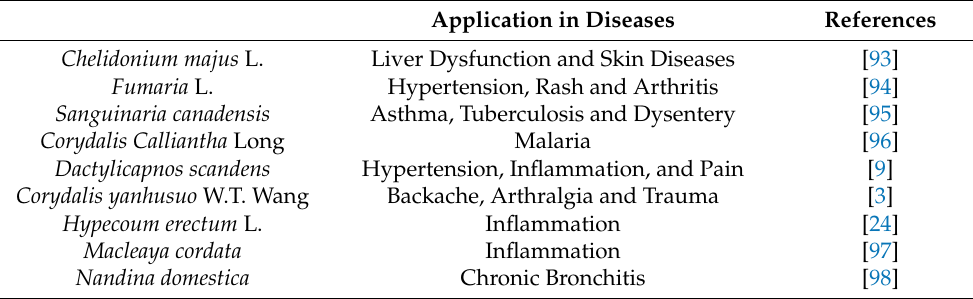
Table 4. Application in diseases of the botanical preparations containing